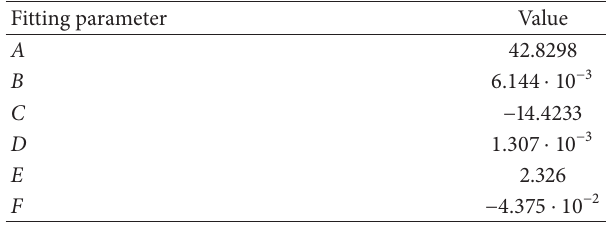
Table 6: The specific value of the fitting parameters.